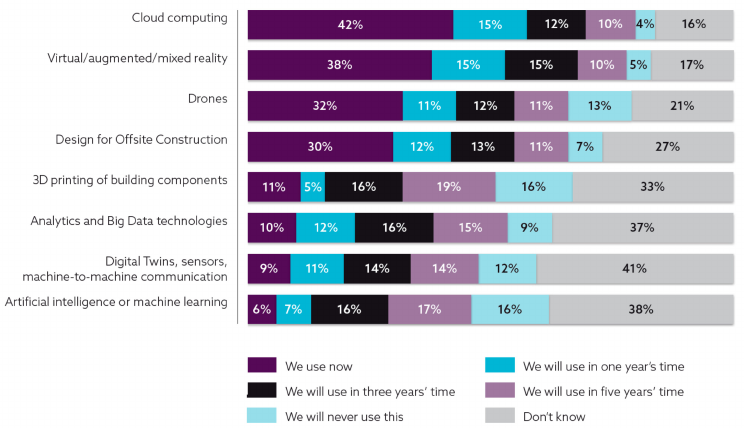
Figure 4. Survey responses to the statement “Please tell us about your current and expected use of the following technologies”. This survey was carried out before COVID-19 lockdowns began in the UK. It would be reasonable to think that the use of these technologies has increased since then. Source: NBS BIM Report